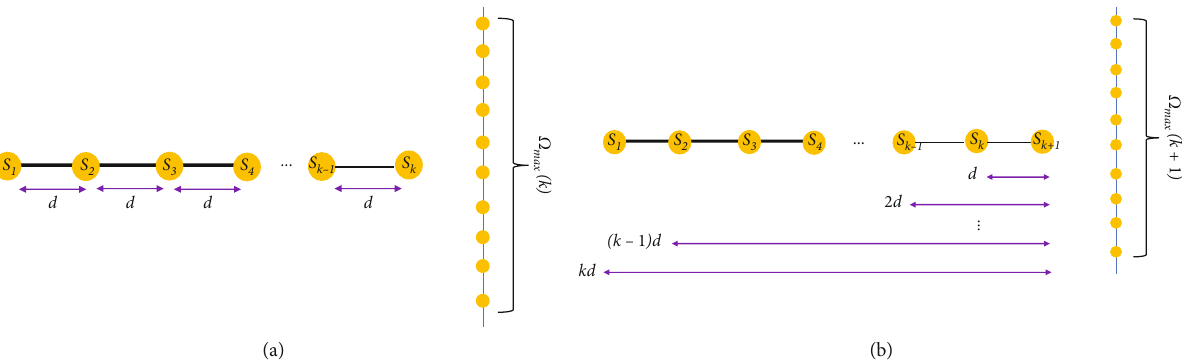
Figure 8: When the screen (blue line) is oriented perpendicular to the line joining a multiple point source arrangement (black line), the total fringe count for ð k + 1 Þ point sources (b) is equal to total fringe count for k point source (a) added to the counts for the pair-wise combinations of the S k +1th point source with each of the other point sources f S 1 , S 2 , S 3 , ⋯ , S k g